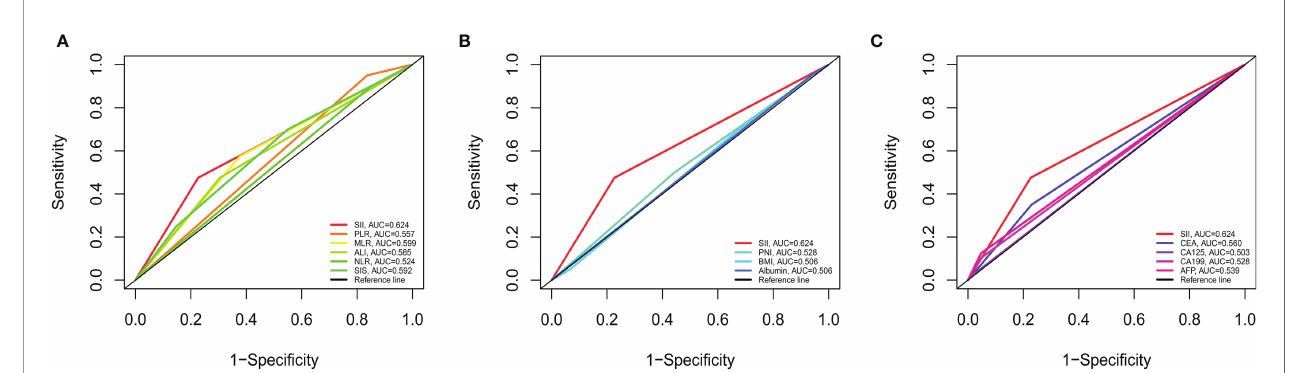
FIGURE 5 | Predictive abilities of SII and other hematological indices for OS examined using t-ROC curves. (A) Predictive ability of SII and immunoin fl ammatory indices. (B) Predictive ability of SII and nutritional indices. (C) Predictive ability of SII and tumor markers. NLR, neutrophil to lymphocyte ratio; PLR, platelet to lymphocyte ratio; MLR, monocyte to lymphocyte ratio; ALI, advanced lung cancer in fl ammation index; SII, systemic immune-in fl ammation index; SIS, systemic in fl ammation score; PNI, prognostic nutritional index; BMI, body mass index; CEA, carcinoembryonic antigen; CA125, cancer antigen 125; CA19-9, carbohydrate associated antigen 19-9; AFP, alpha-fetoprotein.